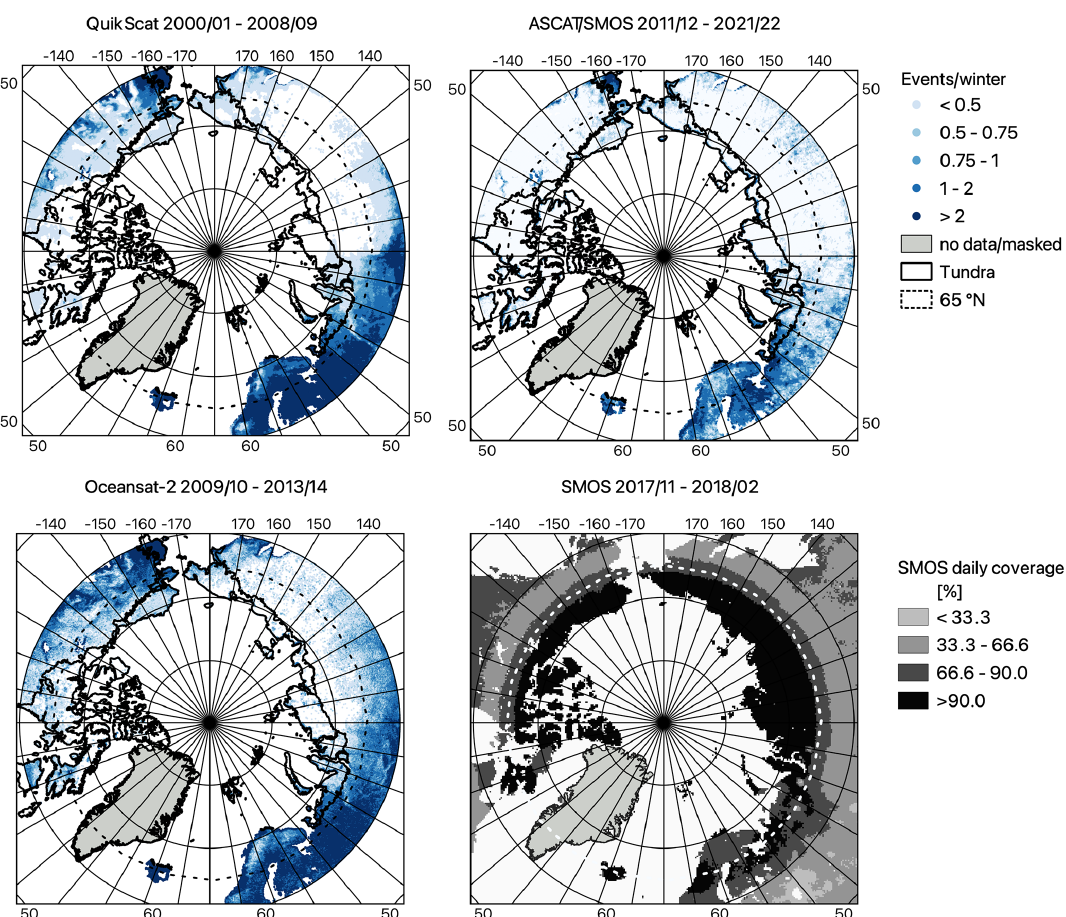
Figure 7. Average potential events per winter and grid cell for each product and example for SMOS data coverage. Boundaries for time-series analysis extent (Fig. 9) are indicated (tundra extent source: CAVM; Raynolds et al.,